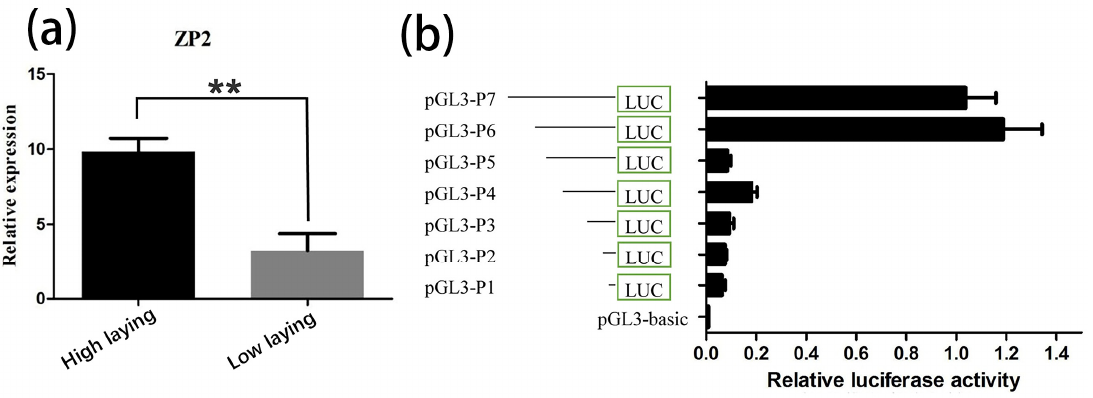
Figure 2. ZP2 gene expression in ovarian tissues and different promoter activity in DF-1 cells. ( a ). ZP2 gene expression in ovarian tissues of high- and low-laying Jinghai yellow chickens. “**”: Where p < 0.01 is marked as “**”, which means that the expression between the high-laying and low-laying groups have significant difference. ( b ). The activity of the different promoters of the ZP2 gene in DF-1 cells.